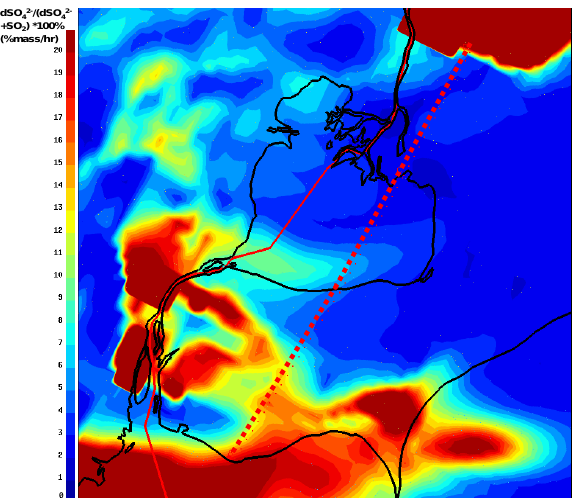
Fig. 13. Model-predicted SO 2 − 12:00LT for the study domain at 285ma.g.l. Dashed red line is the aircraft transect.